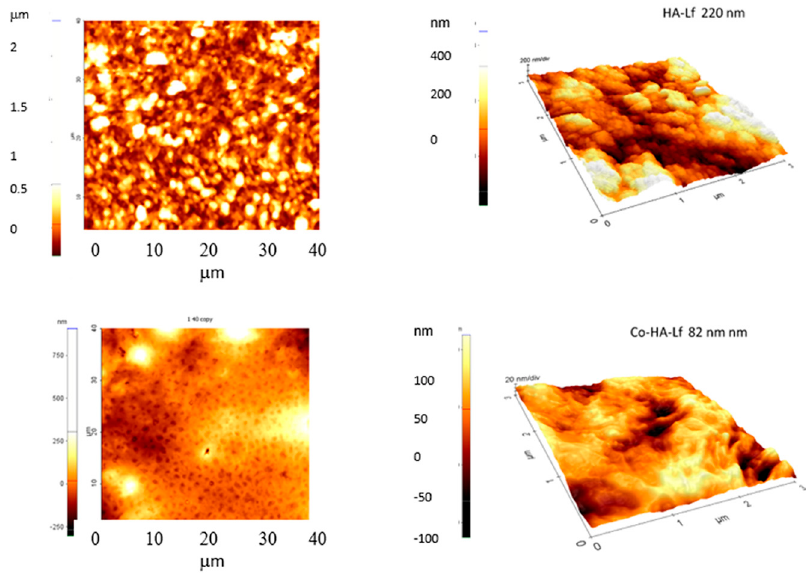
Figure 2. AFM images (40 µ m × 40 µ m) of single component coatings ( A ) and composite coatings ( B ). The right column depicts the detailed image of material organization for single component coatings and composite coatings with 5 µ m × 5 µ m and 3 µ m × 3 µ m, respectively. HA: hydroxyapatite; Lf: lactoferrin.